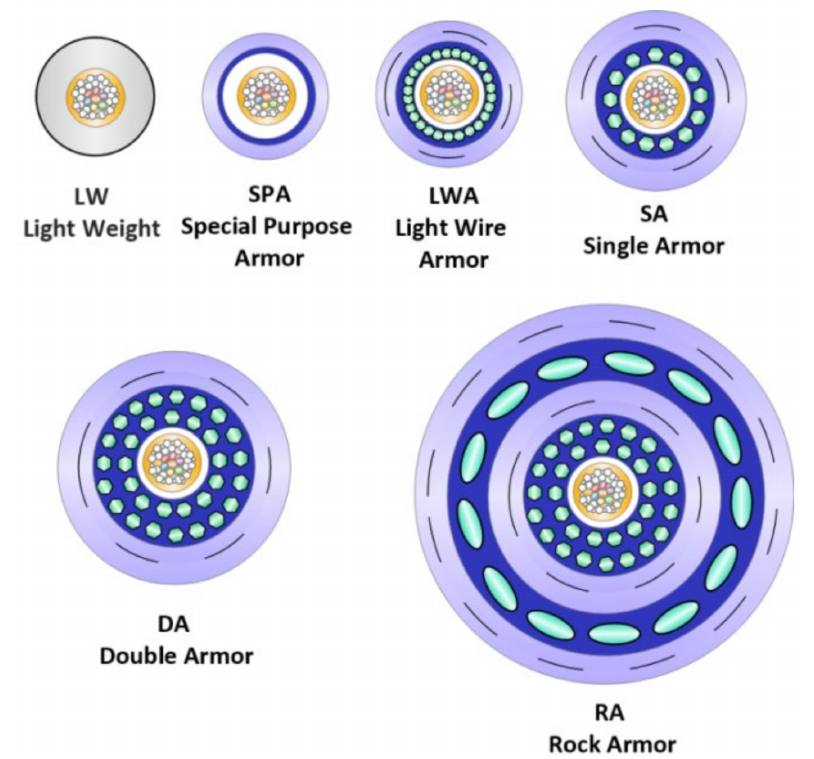
Figure 6. Different types of submarine